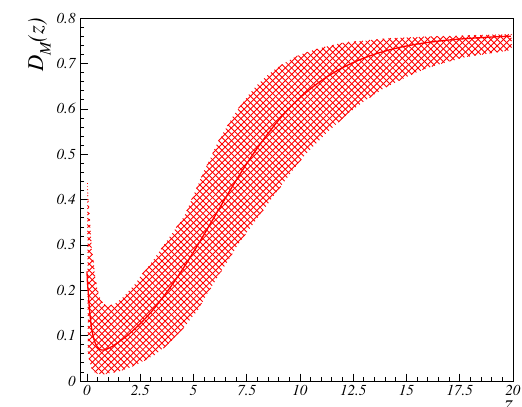
Fig. 1 Depletion factor D M ( z ) , as constrained by the timeline of large structure formation and by the relative amount of baryonic matter per- taining to each type of structure. The width of the band represents the uncertainties on the value of the parameters of D M ( z ) . The central line is obtained for the nominal values of the parameters